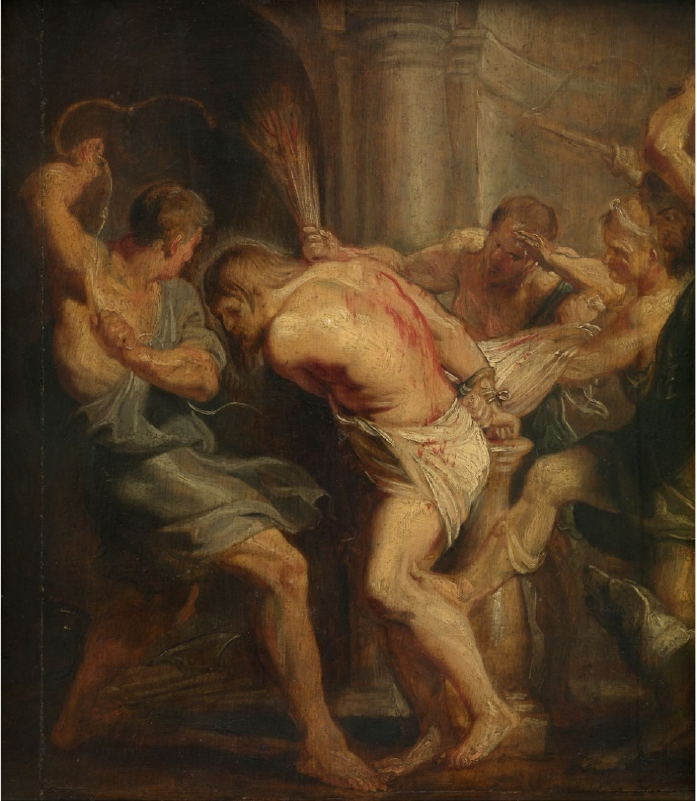
Figure 6. Peter Paul Rubens. The Flagellation of Christ , c. 1650. Museum voor Schone Kunsten, Ghent.